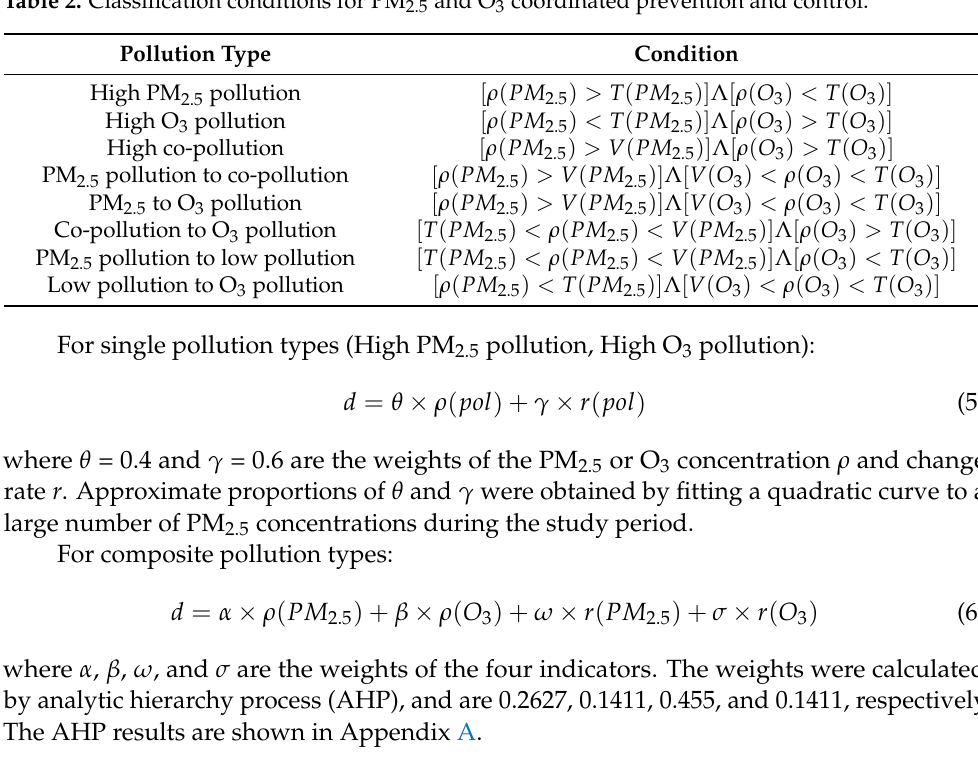
Table 2. Classification conditions for PM 2.5 and O 3 coordinated prevention and